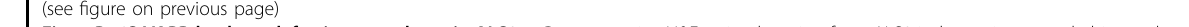
(Fig. 2b, c) further con fi rmed impaired clearance of accumulated autophagosomes.